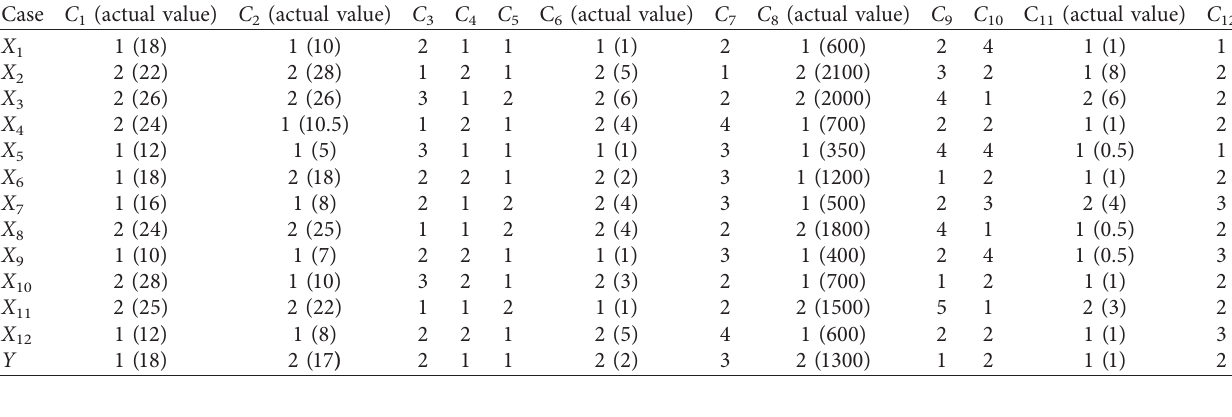
Table 2: Feature information for sample industrial project scheduling control